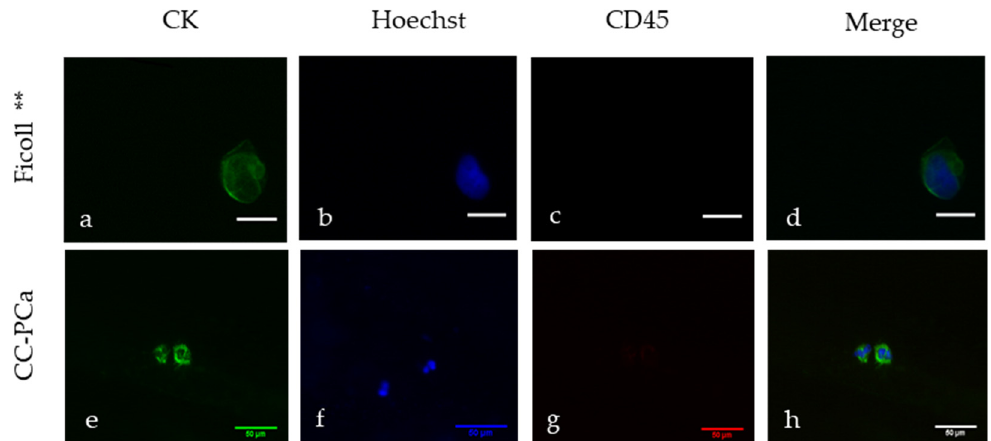
Figure 4. Representative CTC images ( a , e ) and negative leukocyte staining ( c , g ) from selected patients of our cohorts collected by Ficoll ** ( a – d ) and CC-PCa ( e – h ). CTCs were defined as cells with positive staining for CK ( a , e ) but negative staining for CD45 ( c , g ). Hoechst staining showed the presence of cell nucleoli ( b , f ). The scale bars indicate 20 µ m, and cells were scanned at a magnification of 63.3 × ( a – d ). The scale bars indicate 50 µ m, and the cells were scanned at a magnification of 20 × ( e – h ). Merge images are presented in ( d , h ).